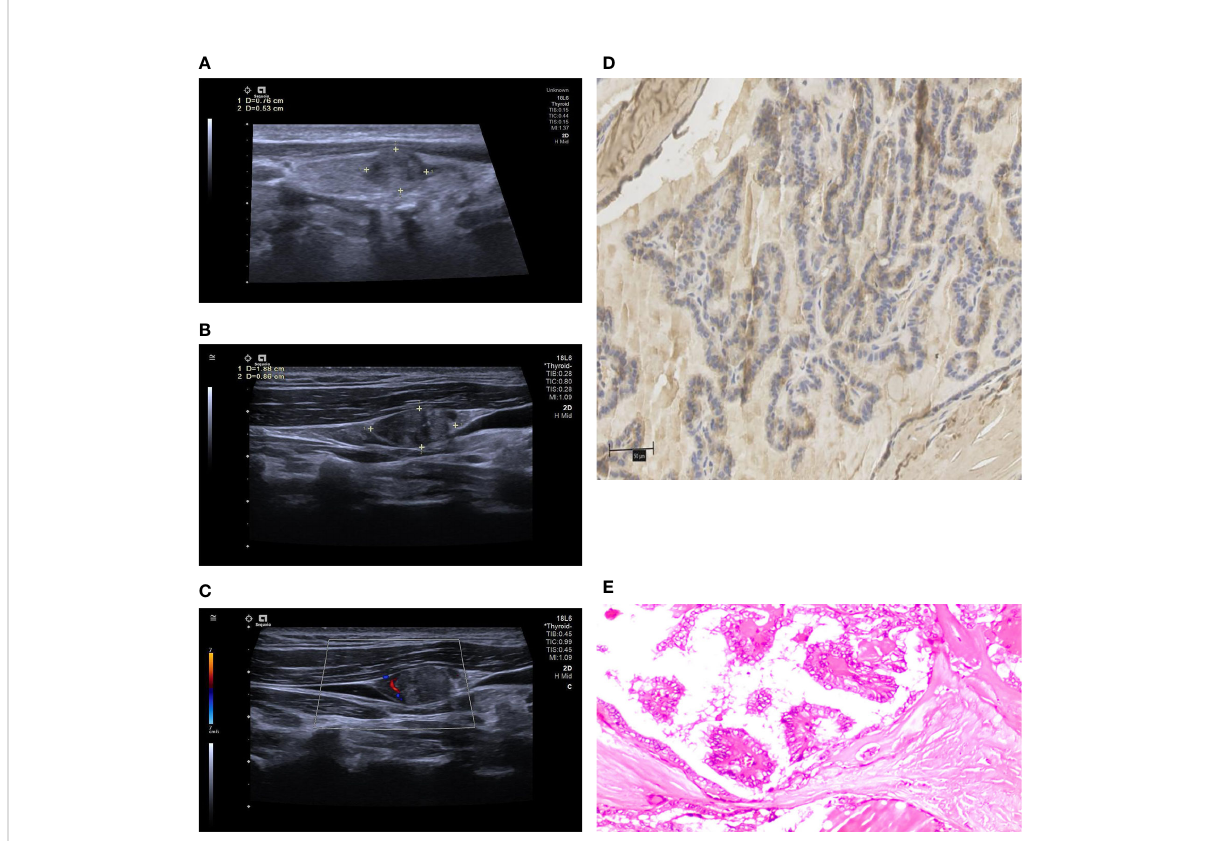
FIGURE 3 The above images were from a 40-year-old male patient. (A) a conventional two-dimensional image. The nodule was 7.6 mm x 5.3 mm in size. (B) the image of ipsilateral cervical lymph node. The size of the lymph node was 18.8 mm x 8.6 mm. The lymphatic hilum structure disappeared, and the boundary between cortex and medulla was unclear. All the characteristics were conformed to US-LNM. (C) CDFI of the lymph node, which showed dotted or linear blood fl ow signals. (D) the high expression of WNT10A. (E) pathological sections of the lesion indicating PTMC.